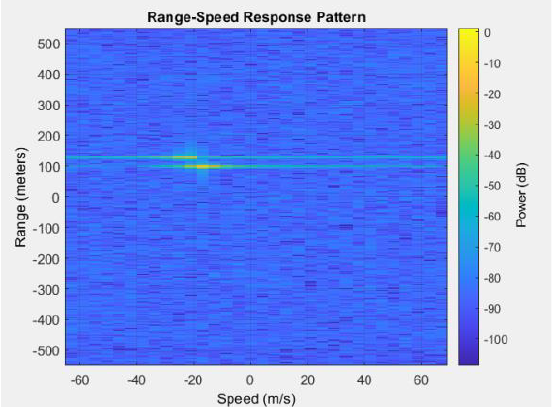
Fig. 8. Range-angle response of two cars moving in a free clutter/jammer environment.